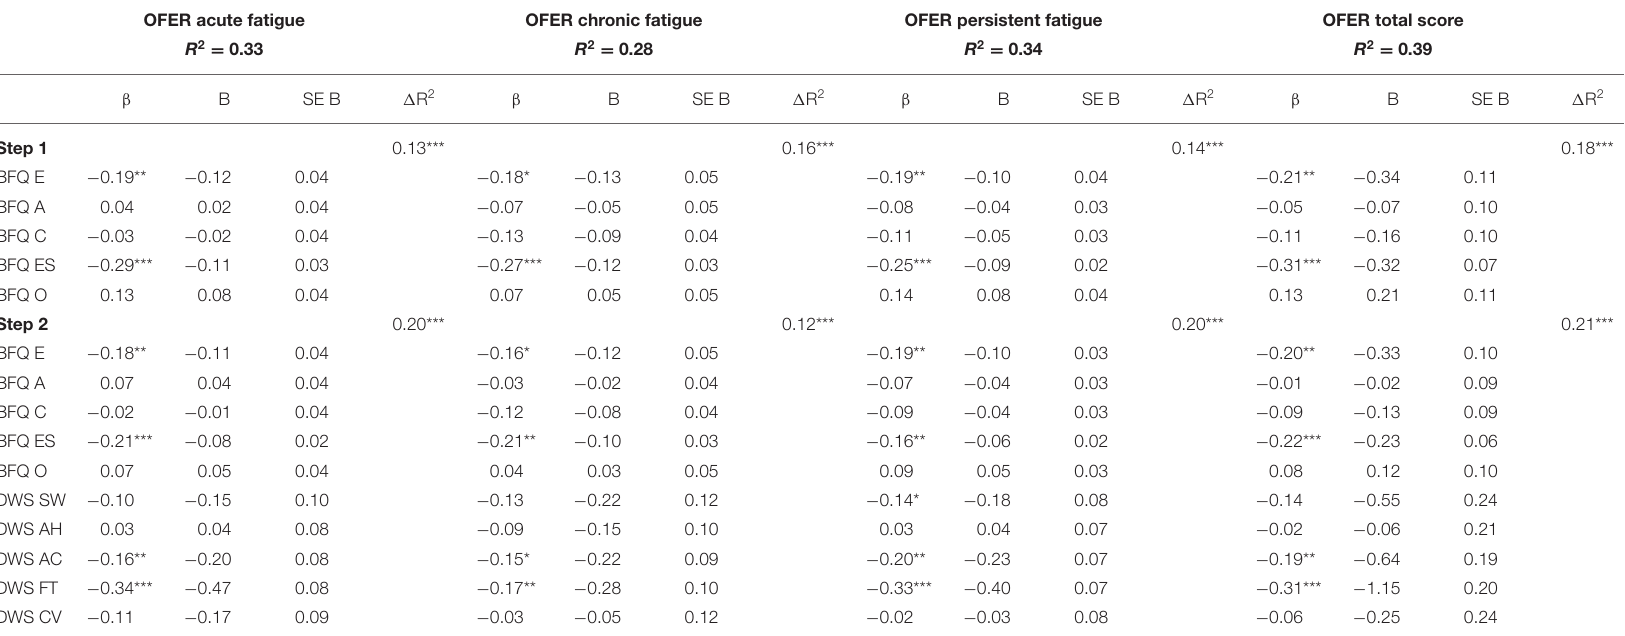
TABLE 2 | Hierarchical regression between Occupational Fatigue Exhaustion Recovery dimensions, Big Five Questionnaire, and Decent